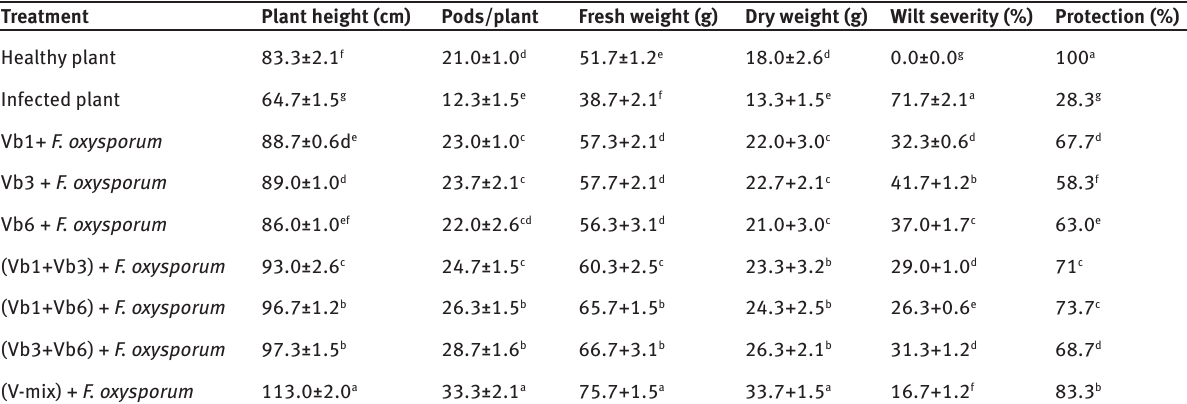
Table 4: The morphological characteristics and wilt disease severity of faba bean plant due to treatment with three rhizospheric bacterial strains Vb1, Vb3, and Vb6 (individually or in a consortium) against F. oxysporum .